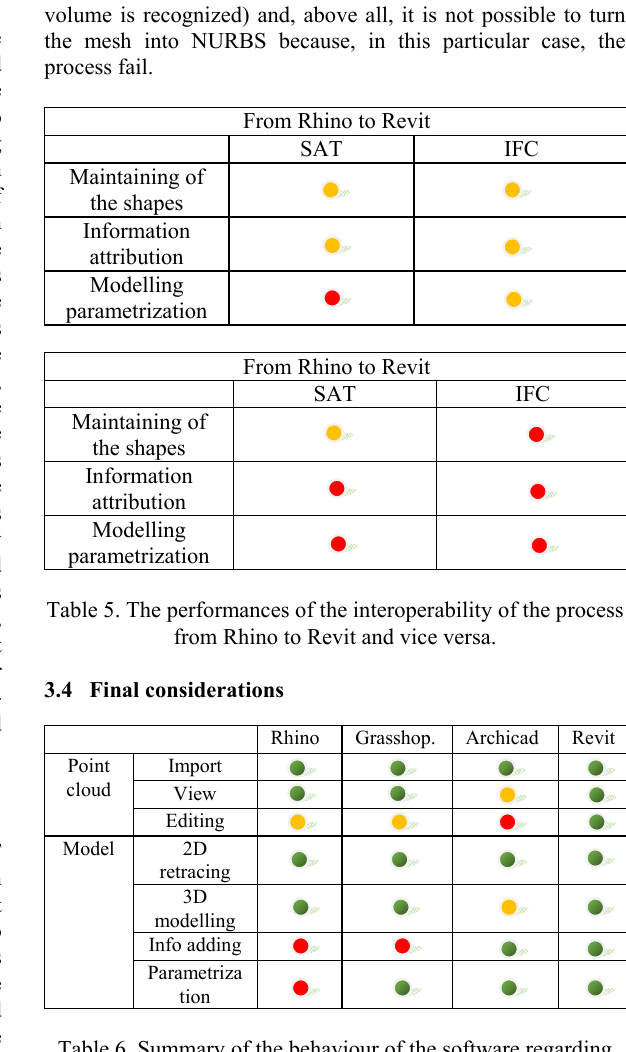
Table 6. Summary of the behaviour of the software regarding the point cloud